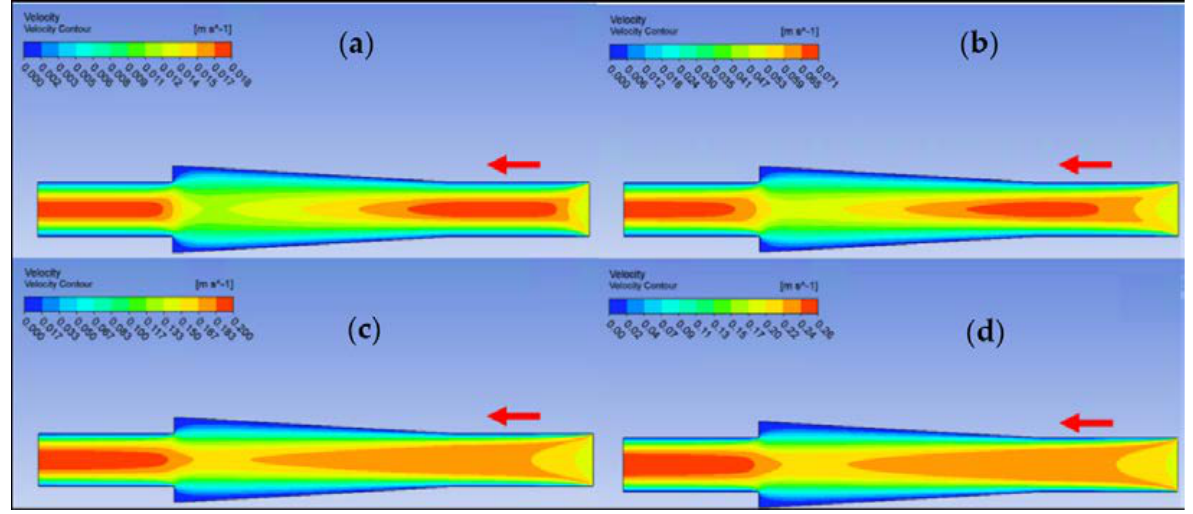
Figure 19. Velocity contour for deionized water in diverging connector. ( a ) Re = 25, ( b ) Re = 100, ( c ) Re = 300, and ( d ) Re = 400.